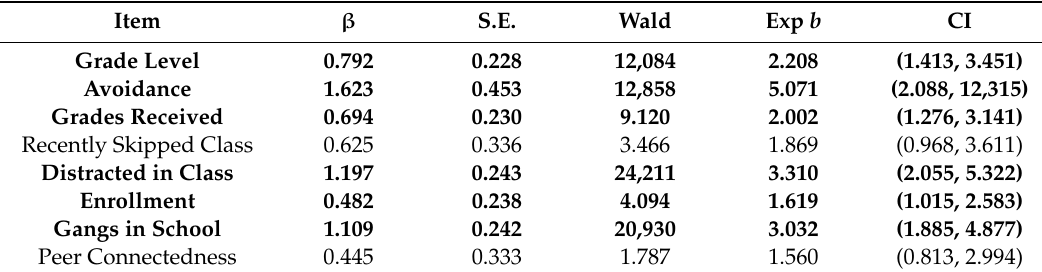
Table 4. Final Logistic Regression Model for Peer